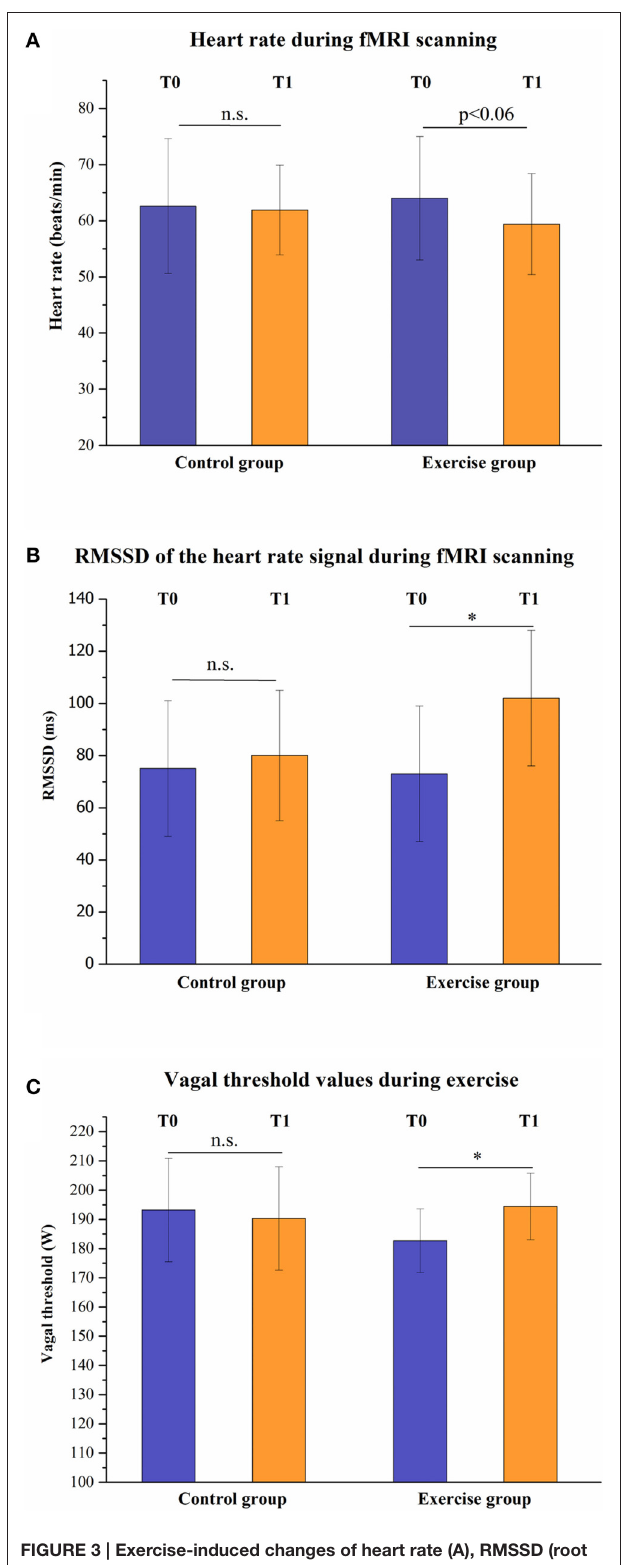
FIGURE 3 | Exercise-induced changes of heart rate (A), RMSSD (root mean square of successive heart beat interval differences, B) and vagal threshold (C) are displayed. * p < 0.05 ; n.s., not